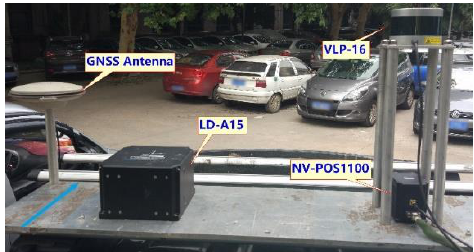
Figure 5 . Experimental platform. Figure 5. Experimental T able 1 Technical Parameters of LD-A15 and NV-POS1100.